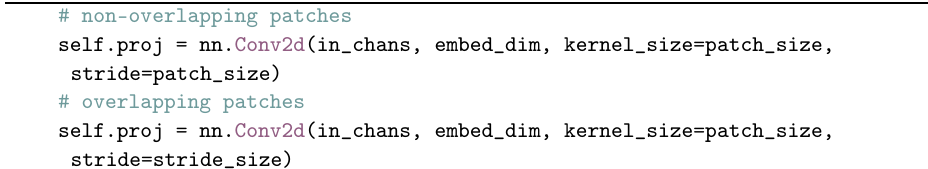
Algorithm 1: PyTorch-style command for non-overlapping vs. overlapping